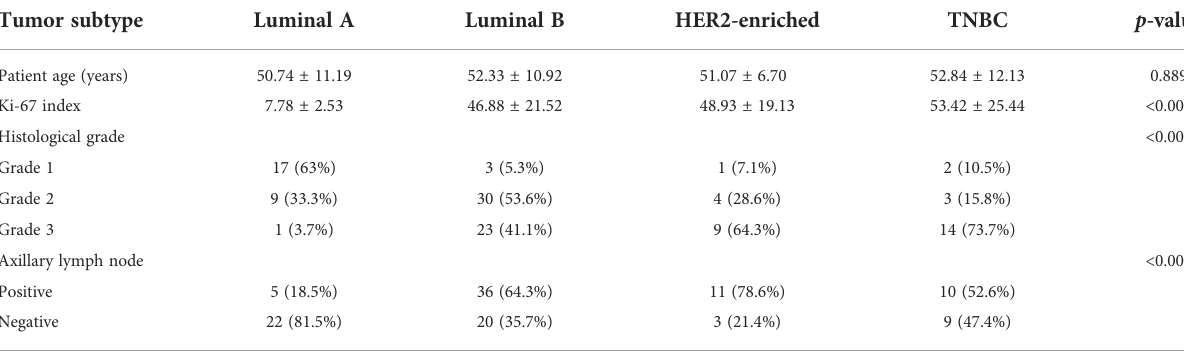
TABLE 1 Clinicopathological features strati fi ed by molecular subtypes. Tumor